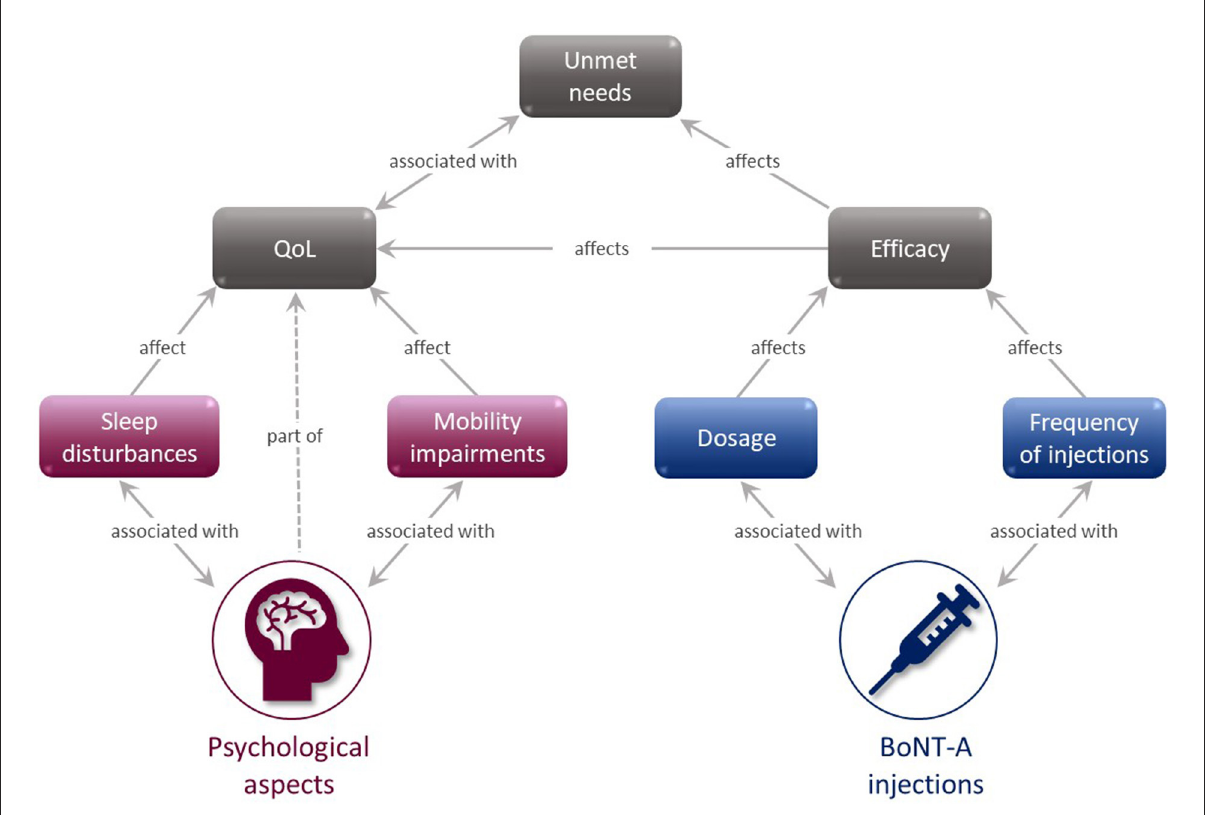
FIGURE8 BoNT-A injection experience mind map. BoNT-A, botulinum neurotoxin A; QoL, quality of